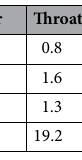
Table 2. Weibull distribution parameters for throat 33 .